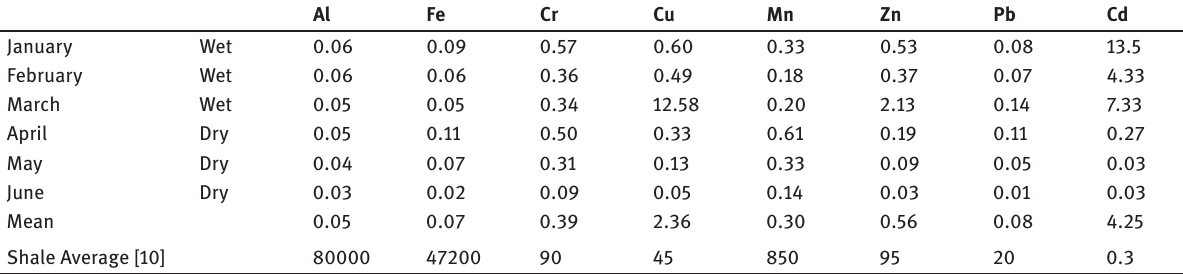
Table 3: Monthly average contamination factor (CF) of trace metals in Nzhelele River sediments.